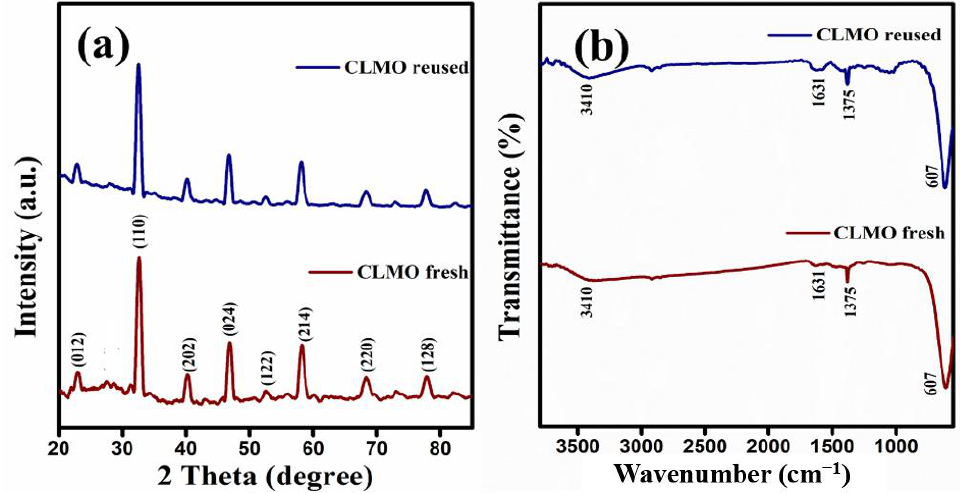
Figure 13. ( a ) XRD patterns and ( b ) FT-IR analysis of the reused and fresh CLMO perovskites.